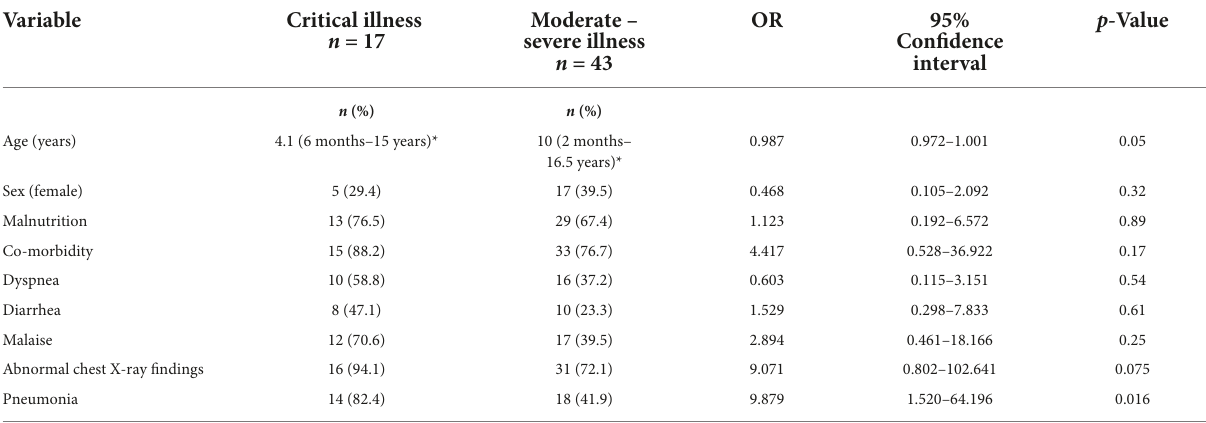
TABLE 5 Logistic regression analysis to determine factors associated to critical illness in hospitalized pediatric patients with COVID-19.